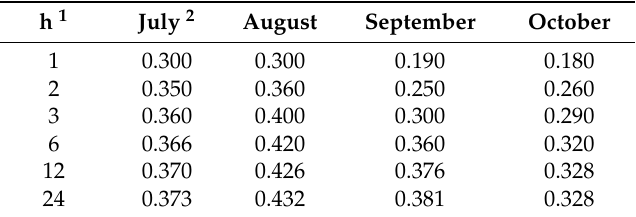
Table 1. Relative yield % of TEOCG over time.